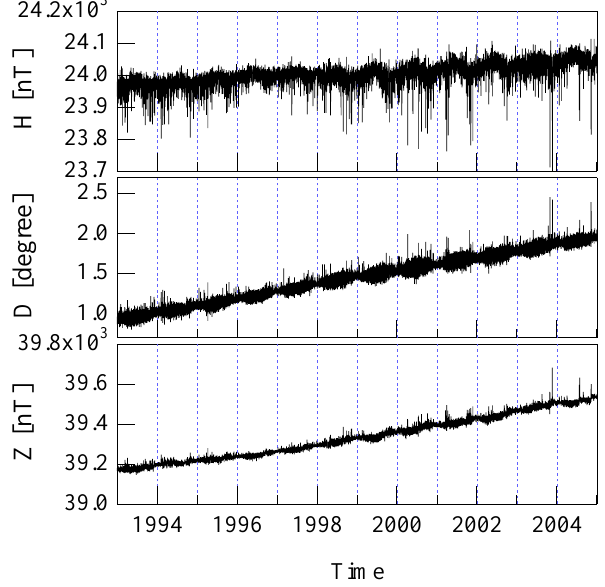
Fig. 1. Hourly means of H, D and Z magnetic field elements (from top to bottom) as recorded at L’Aquila observatory in the period from January 1993 to December